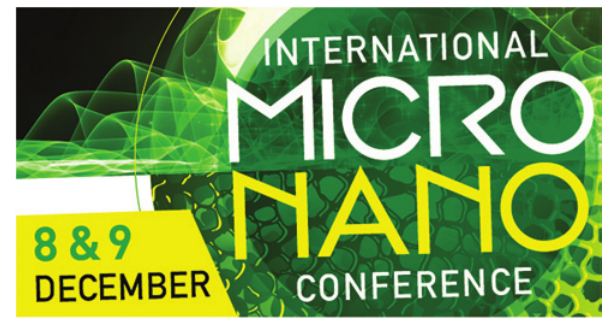
Patrick Tabeling (CNRS / ESPCI, France):